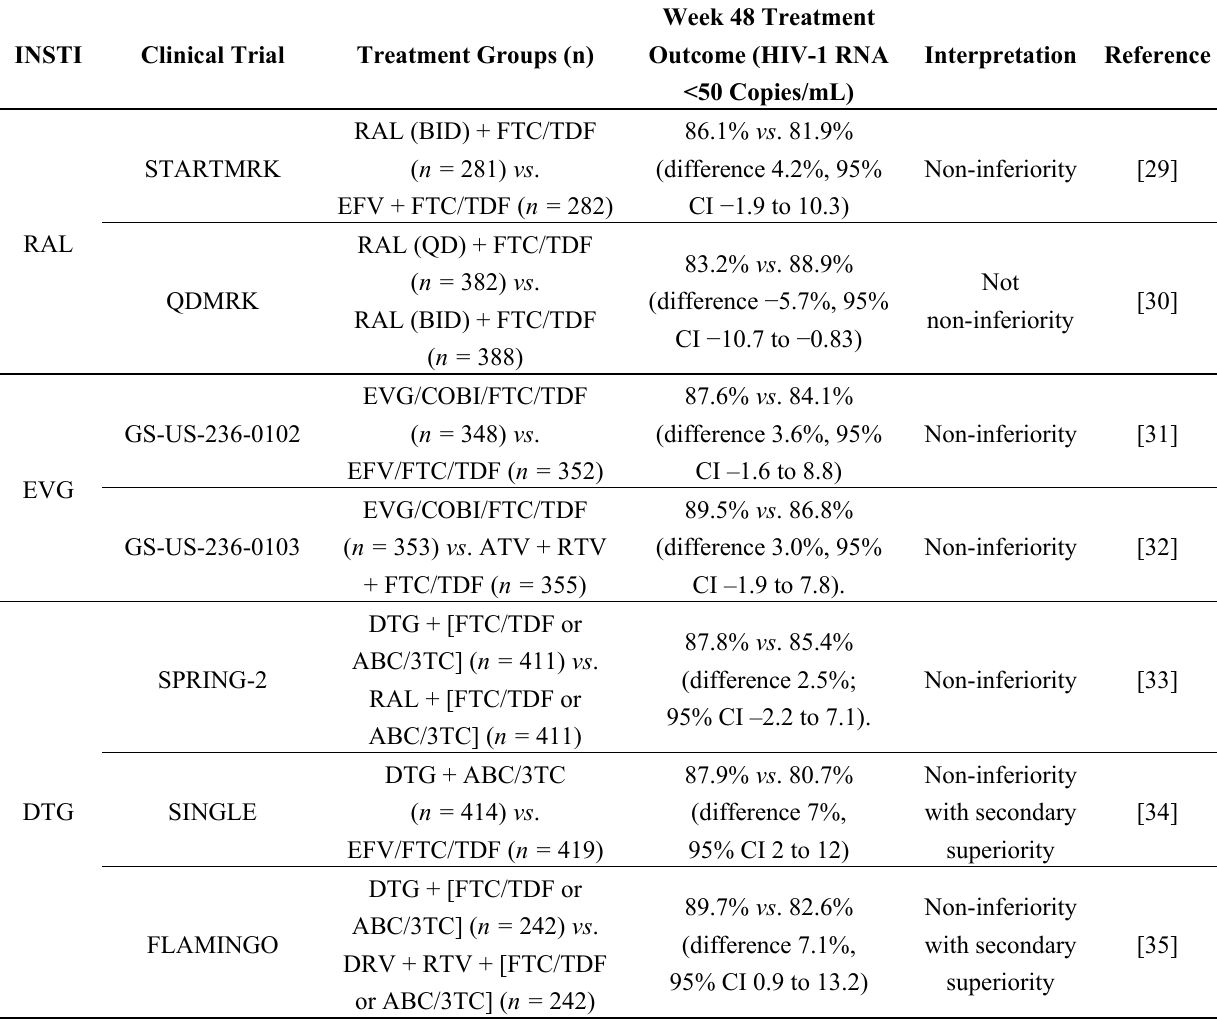
Table 1. Phase 3 clinical trials of integrase strand transfer inhibitor (INSTI)-based regimens as first-line